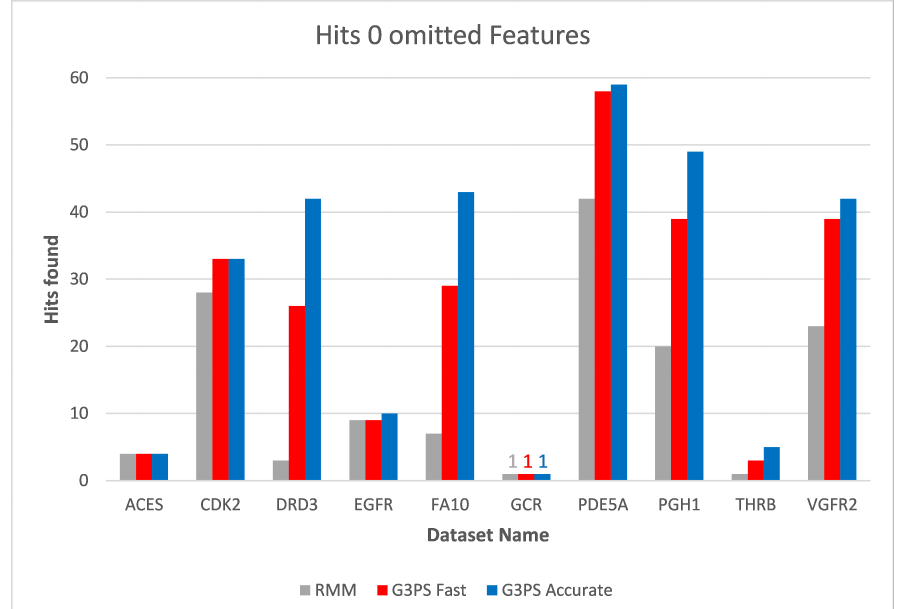
Figure 11. Screening benchmark hits without omitted